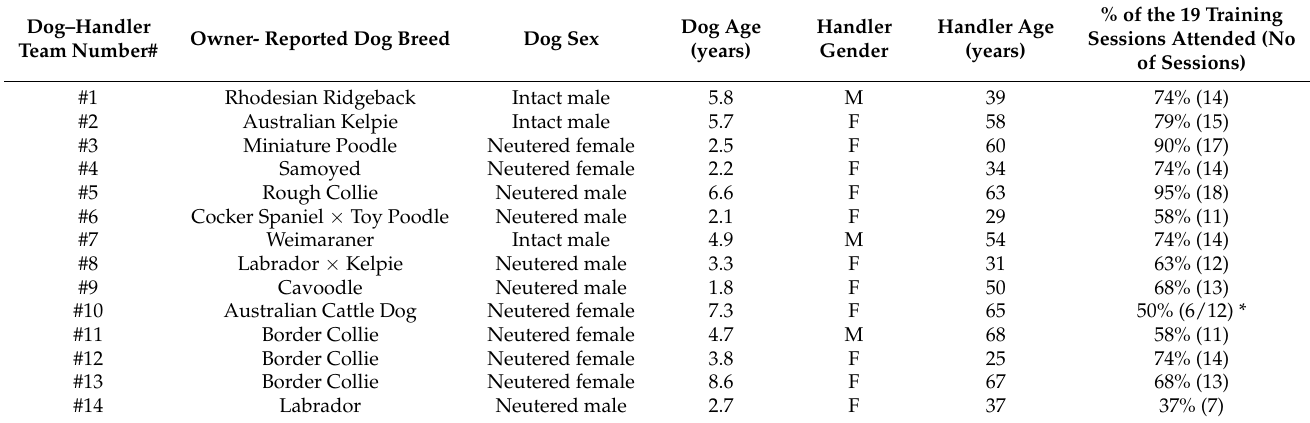
Table 1. Dog–handler team demographic information at the start of the current